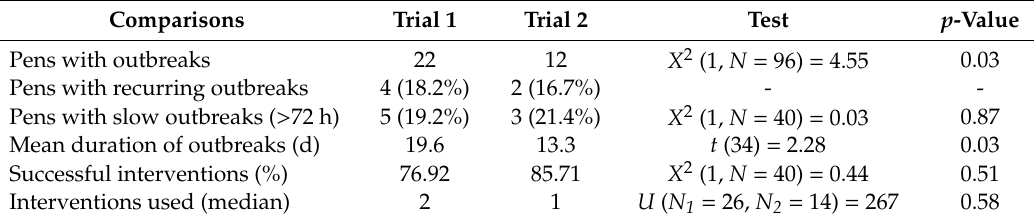
Table 2. Di ff erences in tail biting outbreaks between the two